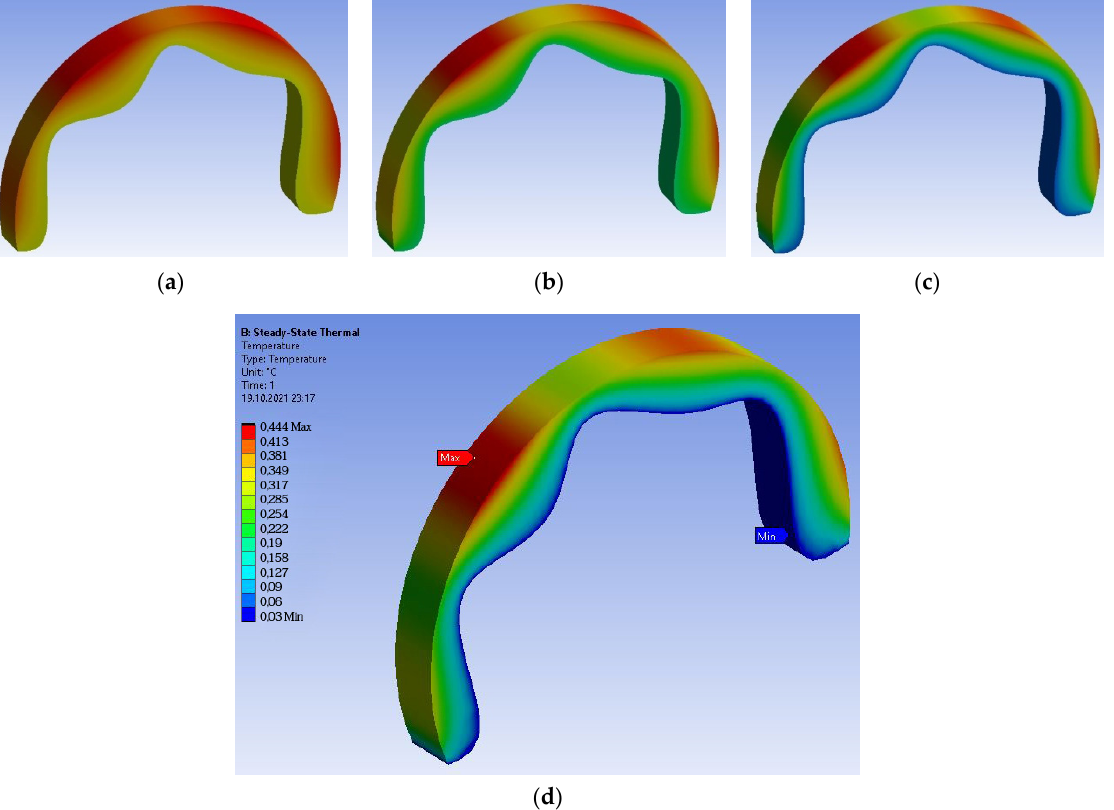
Figure 3. Heat transitions of the model at ( a ) 0.3 s, ( b ) 0.6 s, ( c ) 0.9 s and ( d ) 1 s.